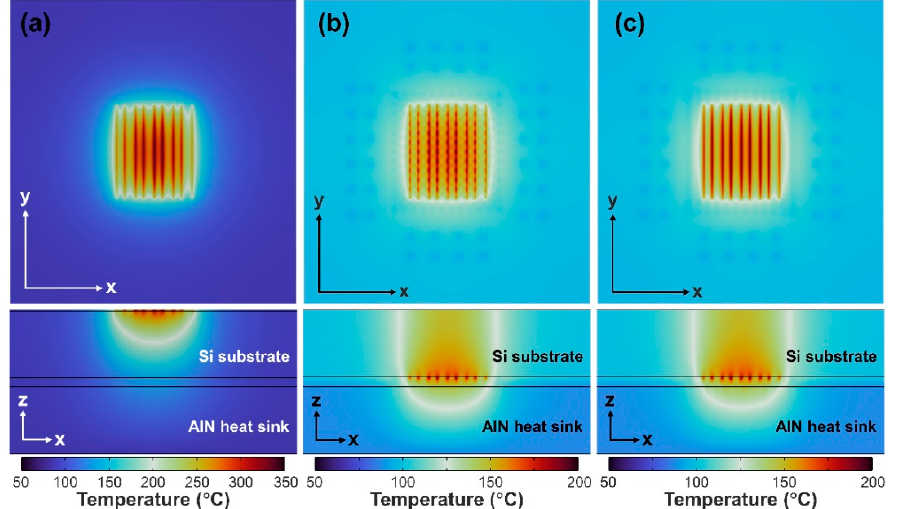
Figure 4. Temperature distributions of GaN HEMTs with nine gate fingers operated at V DS = 12 V and T amb = 360 K for ( a ) FU-0, ( b ) FC-1 and ( c ) FC-2 bonding schemes. The x–z cross-section is cut along the center of the AlGaN channel.